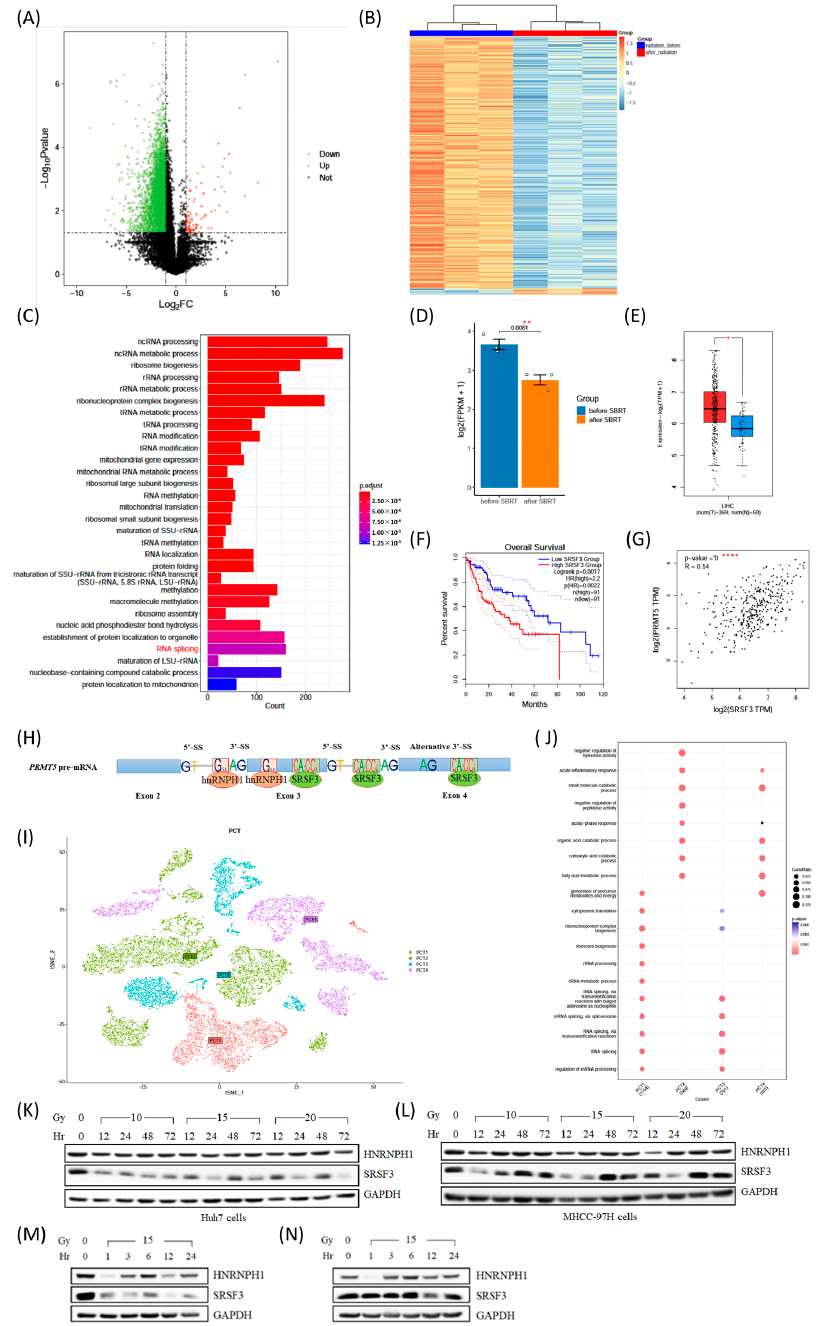
Figure 2. IR-induced PRMT5-ISO5 production is regulated by SRSF3 and HNRNPH1 in HCC cells. ( A ) Significantly differential expression of genes is shown in a volcano plot. ( B ) Clustering analysis is shown in the heatmap. ( C ) GO analysis was performed, and the top 30 enriched pathways are shown in bar charts. ( D ) The expression level of SRSF3 in HCC patients who received SBRT (n = 3). ( E , F ) Bioinformatics analysis of LIHC patients and normal controls based on GEPIA2. ( E ) The differential expression of SRSF3. ( F ) The overall survival analysis diagram of SRSF3. ( G ) The correlation analysis of PRMT5 and SRSF3. * p < 0.05, ** p < 0.01, **** p < 0.0001. ( H ) The predicted RNA target regions and motifs bound by SRSF3 and HNRNPH1. ( I ) t-SNE of 4 cell populations from scRNA-seq datasets (GSE149614). ( J ) GO enrichment analysis of the 4 cell populations. ( K – N ) The expression level of SRSF3 and HNRNPH1 in Huh7 and MHCC-97H cells induced by IR at different time